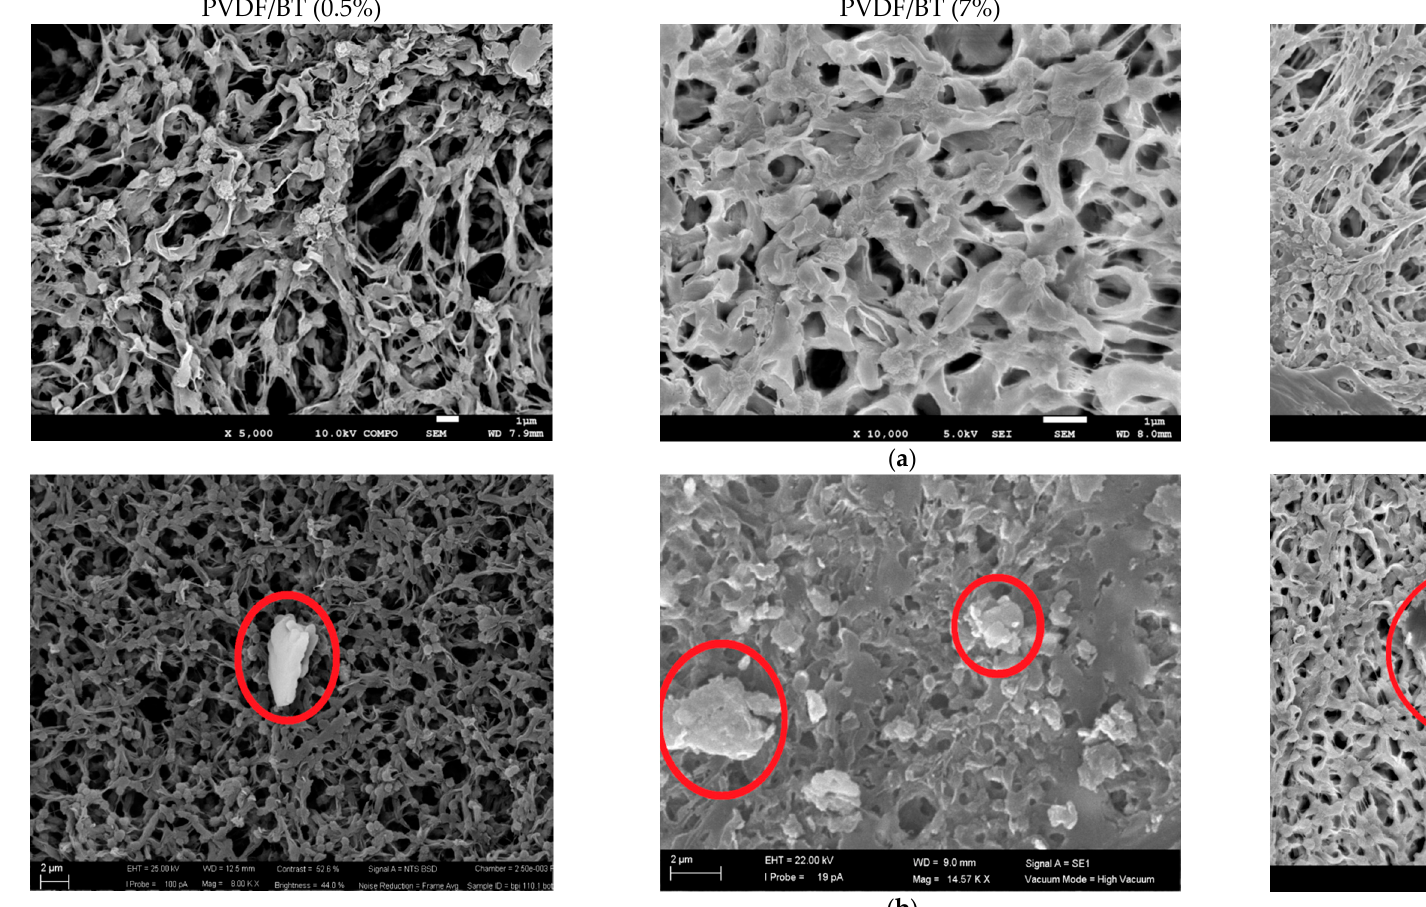
Figure 1. ( a ) SEM micrographs collected on the top surface of PVDF/BT (0.5%), PVDF/BT (7%) and PVDF/G (0.5%) membranes; ( b ) 2D fillers enclosed in the various membrane networks.